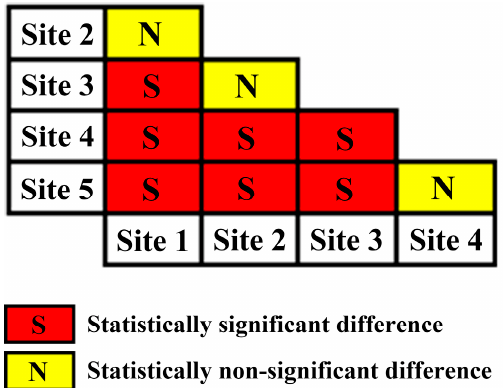
Figure 3. Significance test for slope difference of the maximum size-density line in the 5 different site quality categories classified based on site index.